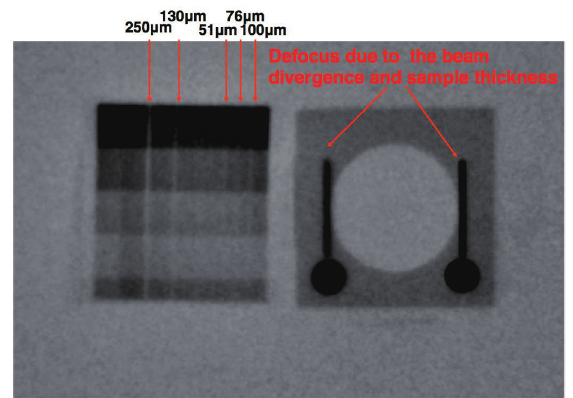
Figure 2. Neutron transmission Image of the ASTM neutron indicator